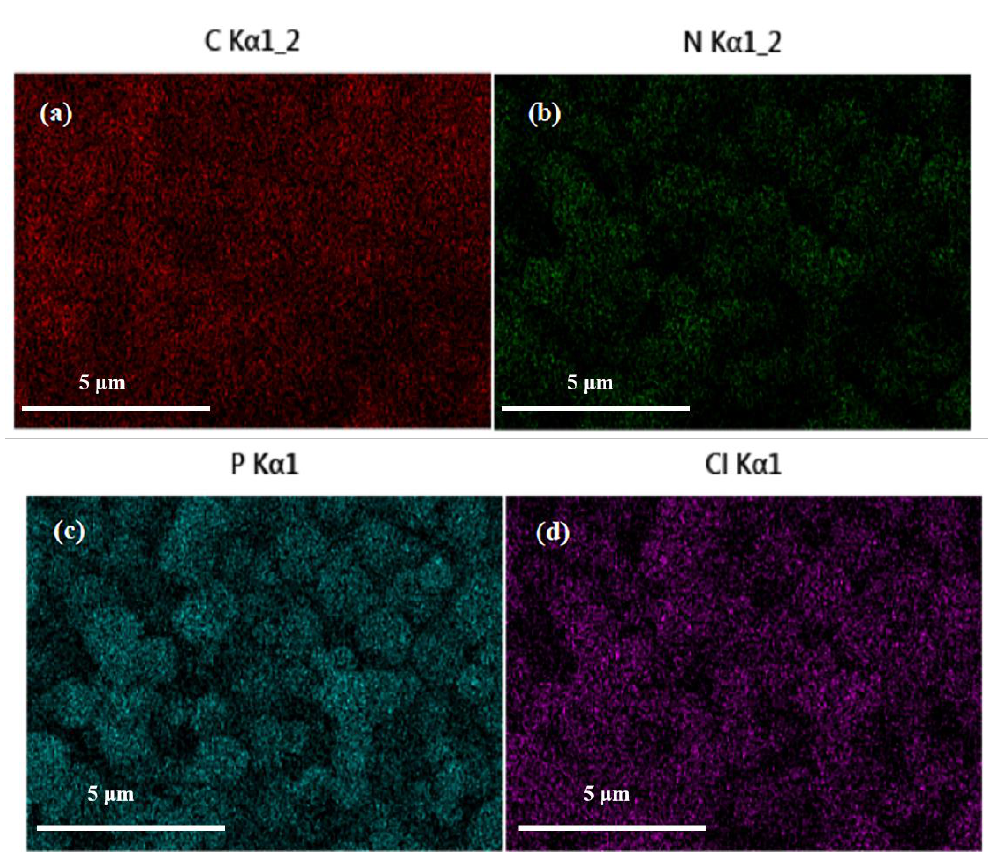
Figure 3. EDS mappings of characteristic elements of 15% P-SSCN, ( a ) C-element scan map, ( b ) N- element scan map, ( c ) P-element scan map, ( d ) Cl-element scan map.